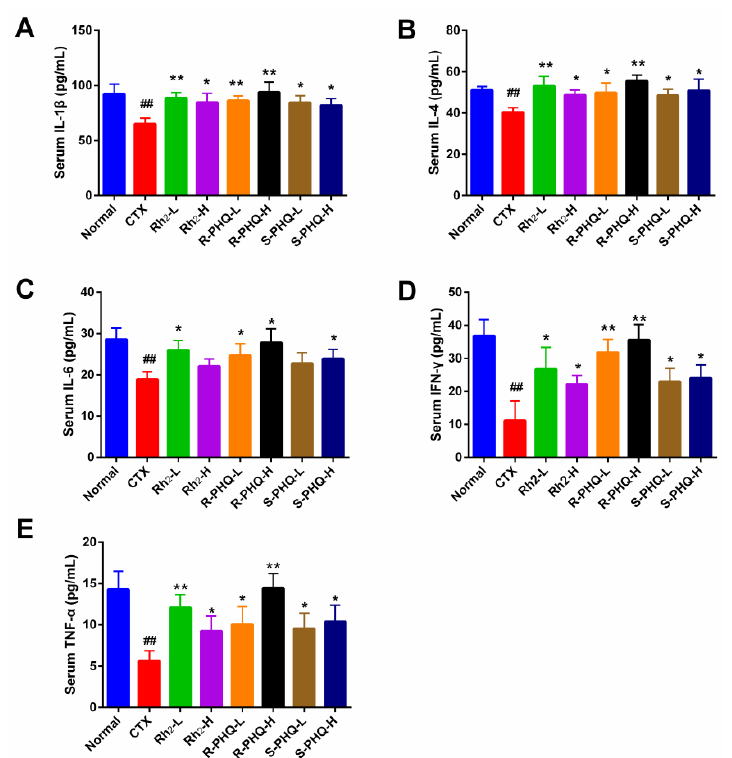
Figure 5. Effect of Rh 2 , R-PHQ, and S-PHQ on the serum levels of ( A ) IL-1 β ; ( B ) IL-4; ( C ) IL-6; ( D ) IFN- γ ; ( E ) TNF- α . The values are presented as mean ± SD, n = 8. ## p < 0.01 compared with the normal group. ** p < 0.01 and * p < 0.05 compared with the CTX group.